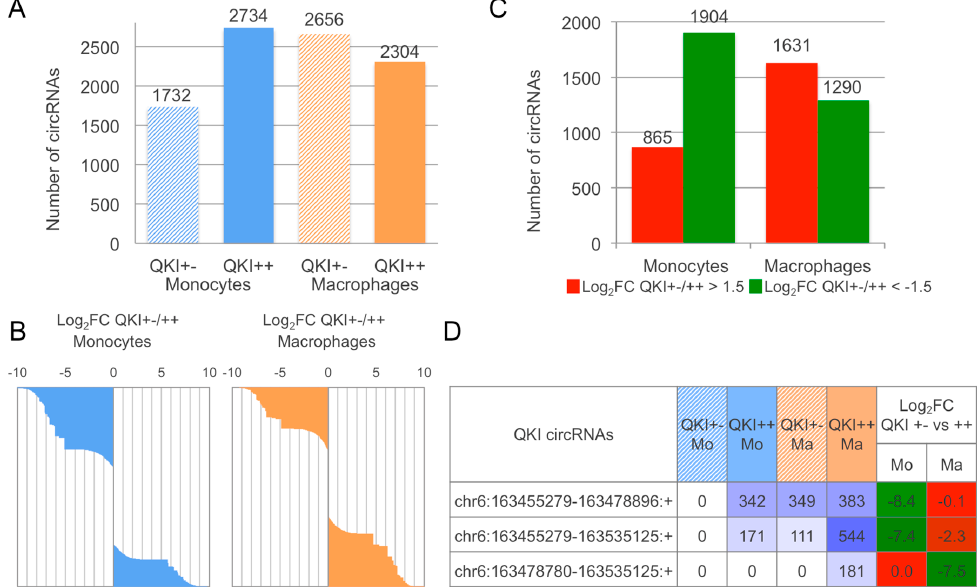
Figure 3. circRNAome expression varies in relation to Quaking (QKI) haploinsufficiency during monocyte to macrophage induced differentiation. ( A ) number of circRNAs expressed per sample; ( B ) waterfall plot of log 2 FC in the QKI +/ − vs. QKI +/+ in the two cell types, for all the expressed circRNAs; ( C ) number of circRNAs with absolute log 2 FC > 1.5 or < − 1.5 when comparing QKI haploinsu ffi cient with control cells, separately considering monocytes and macrophages; ( D ) QKI circular isoforms detected from RNA ‐ seq (the table indicates for each circRNA the genomic coordinates of the back ‐ splice ends, the expression level per sample and the intensity of observed log 2 FC).